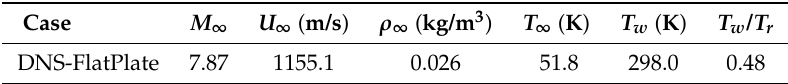
Table 1. Freestream and wall-temperature conditions for the direct numerical simulation (DNS) of a Mach 8 turbulent boundary